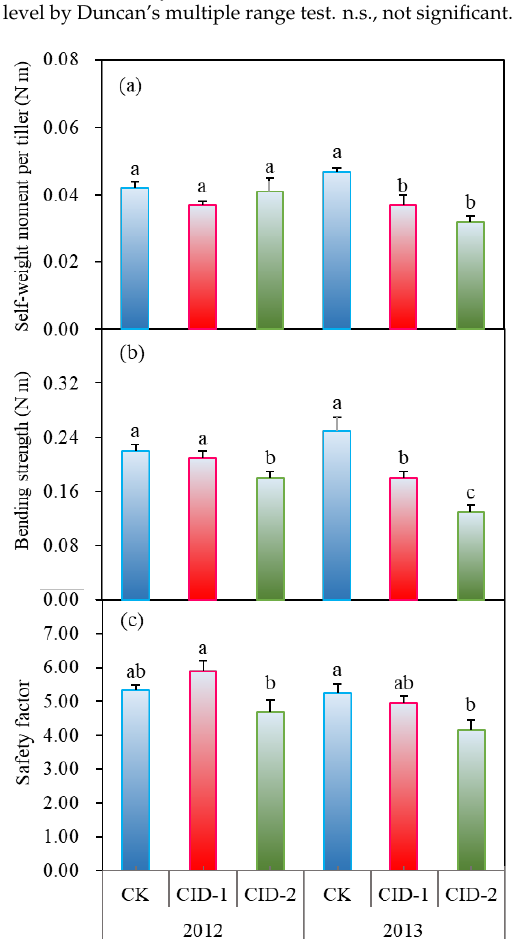
Figure 2. Effects of irrigation regimes on the ( a ) self-weight moment per tiller, ( b ) bending strength, and ( c ) safety factor of rice plants under different irrigation regimes during the rice growing season of 2012 and 2013. Data are means ± SE of six replicates. The different letters on the tops of columns for the same year indicate significant differences between treatments at 5%, according to Duncan’s multiple range test.